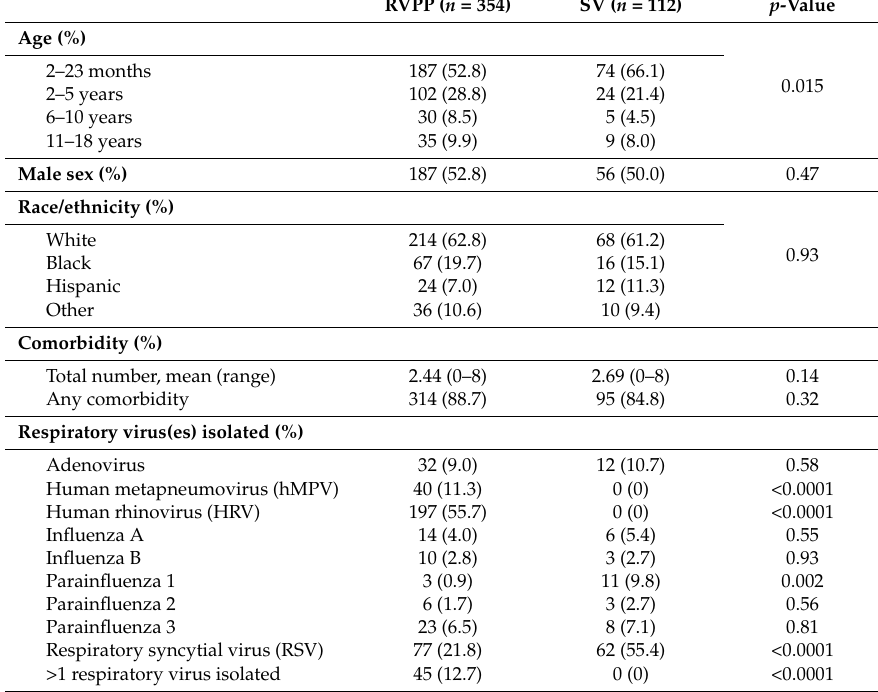
Table 1. Characteristics of the total study populations who tested positive using respiratory virus PCR panel (RVPP) or shell vial (SV) cell